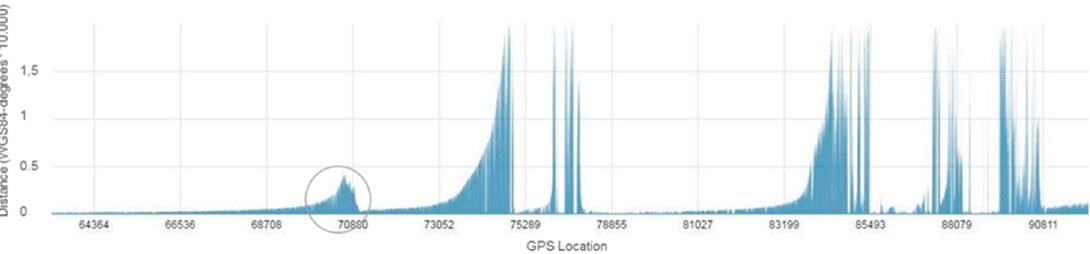
Figure 3. OPTICS diagram with the first significant peak encircled.